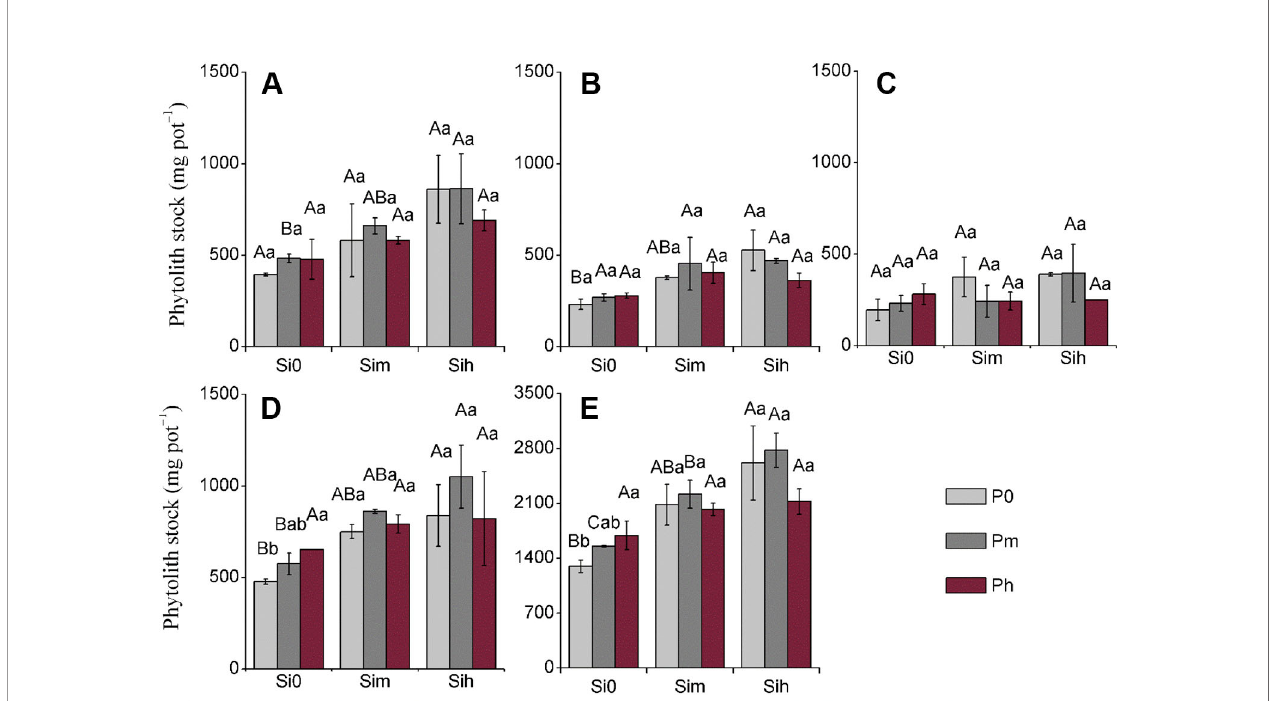
FIGURE 2 | Phytolith stock (mg pot − 1 ) at a two-way analysis of variance of silicon-phosphorus (Si-P) levels in the different plant parts. (A) Leaf; (B) fl ag leaf; (C) : stem; (D) : sheath; (E) rice shoot. Error bars represent the standard deviations of the means. Different lowercase letters indicate signi fi cant differences among the treatments in different P treatments and rice plant parts at a given Si level, respectively [least signi fi cant difference (LSD) test; p ≤ 0.05, n = 5]. Different uppercase letters indicate signi fi cant differences among the treatments in different Si treatments and rice plant parts at a given P level, respectively (LSD test; p ≤ 0.05, n =